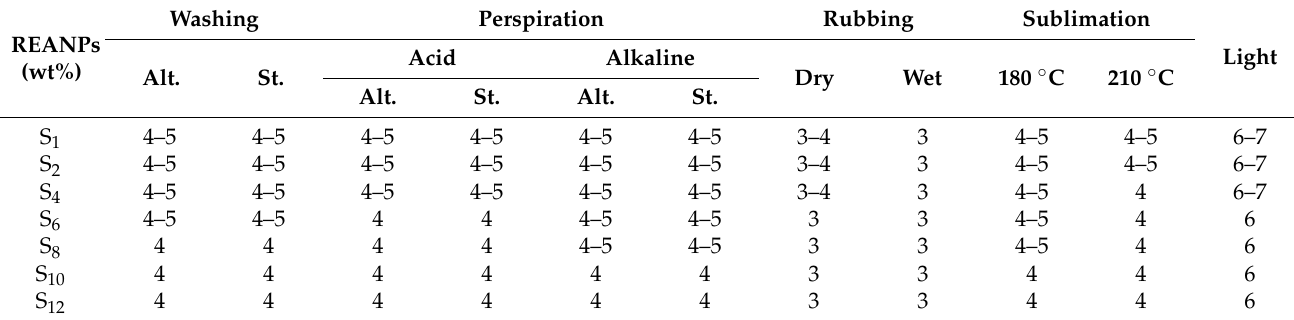
Table 5. Fastness of spray-coated cotton